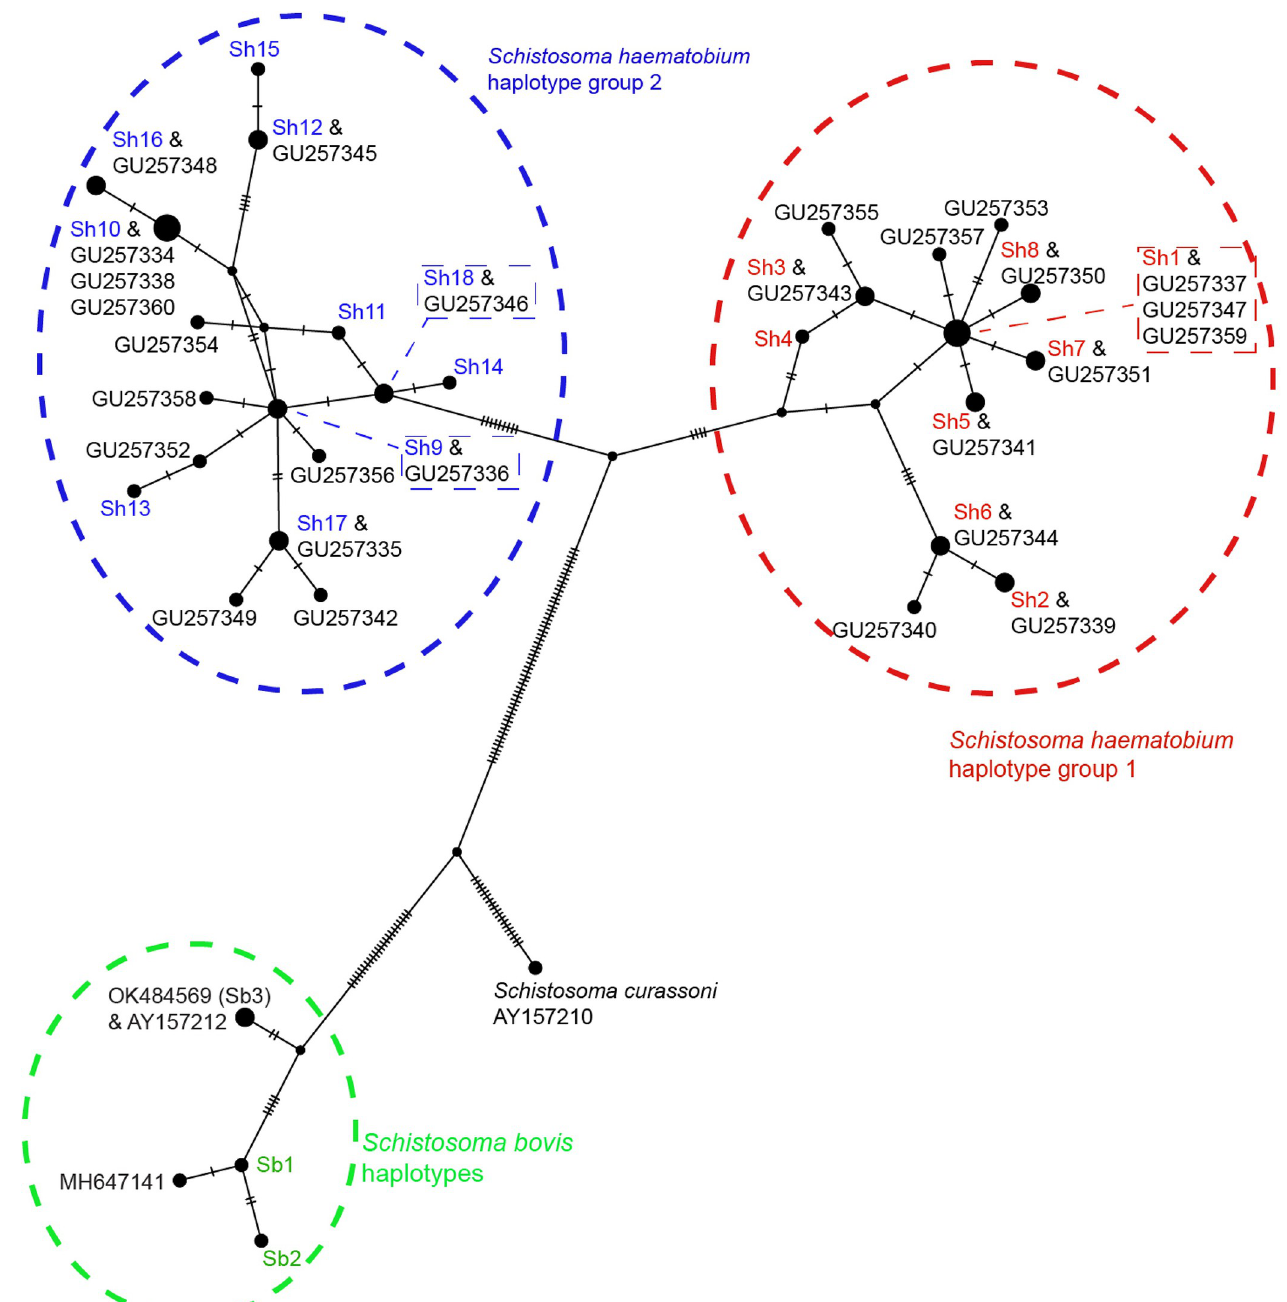
Fig 4. TCS haplotype network of Schistosoma spp. partial cox 1 DNA sequences (750 bp). Produced using PopArt [56]. Hatches represent SNP differences from joined nodes and size of nodes is scaled to the number of identical haplotypes listed. Schistosoma haplotype group 1 and 2 indicates whether cercariae were identified as mainland Africa (1) or Indian Ocean Island (2) haplotypes (as described in Webster et al . [27]). Schistosoma haematobium reference haplotypes (GU257334 –GU257360) from Webster et al . [28]. Schistosoma bovis reference haplotypes (OK484569, AY157212 and MH647141) from Pennance et al . [54], Lockyer et al . [53] and Djuikwo-Teukeng et al . [55], respectively. Schistosoma curassoni reference (AY157210) from Lockyer et al . [53].